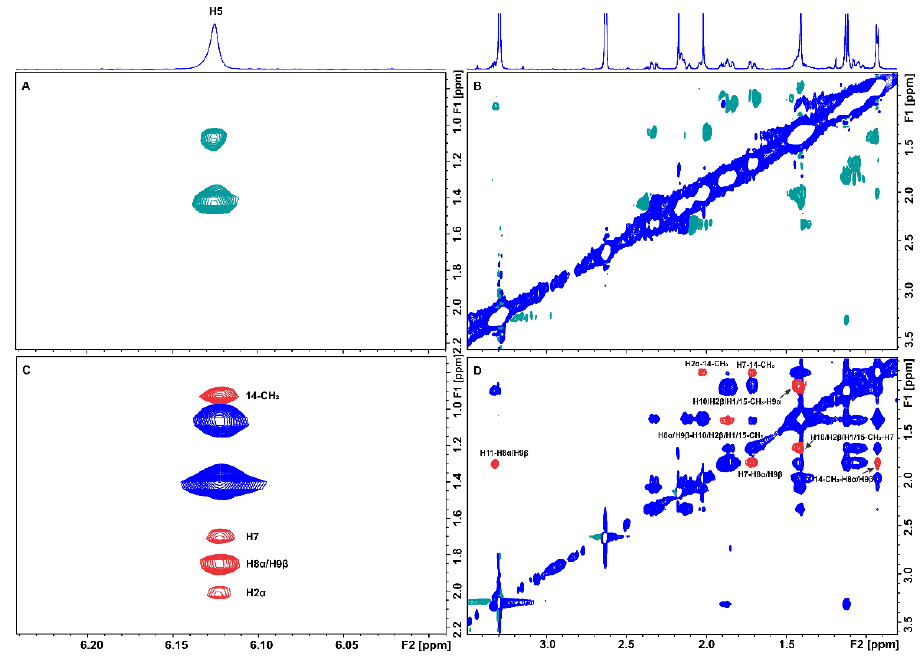
Figure 3. ( A , B ) Selective regions of 2D NOESY NMR spectrum of 2 mM artemisinin in PBS, pD 7.4, D 2 O with 10% DMSO-d 6 . ( C , D ) Selective regions of 2D Tr-NOESY NMR spectrum of 2 mM artemisinin with 20 µ M of BSA in PBS, pD 7.4, D 2 O with 10% DMSO-d 6 . New Tr-NOE cross-peaks are denoted with red color. Mixing time = 300 ms, T = 310 K, number of scans = 112, and experimental time = 17 h 19 min.